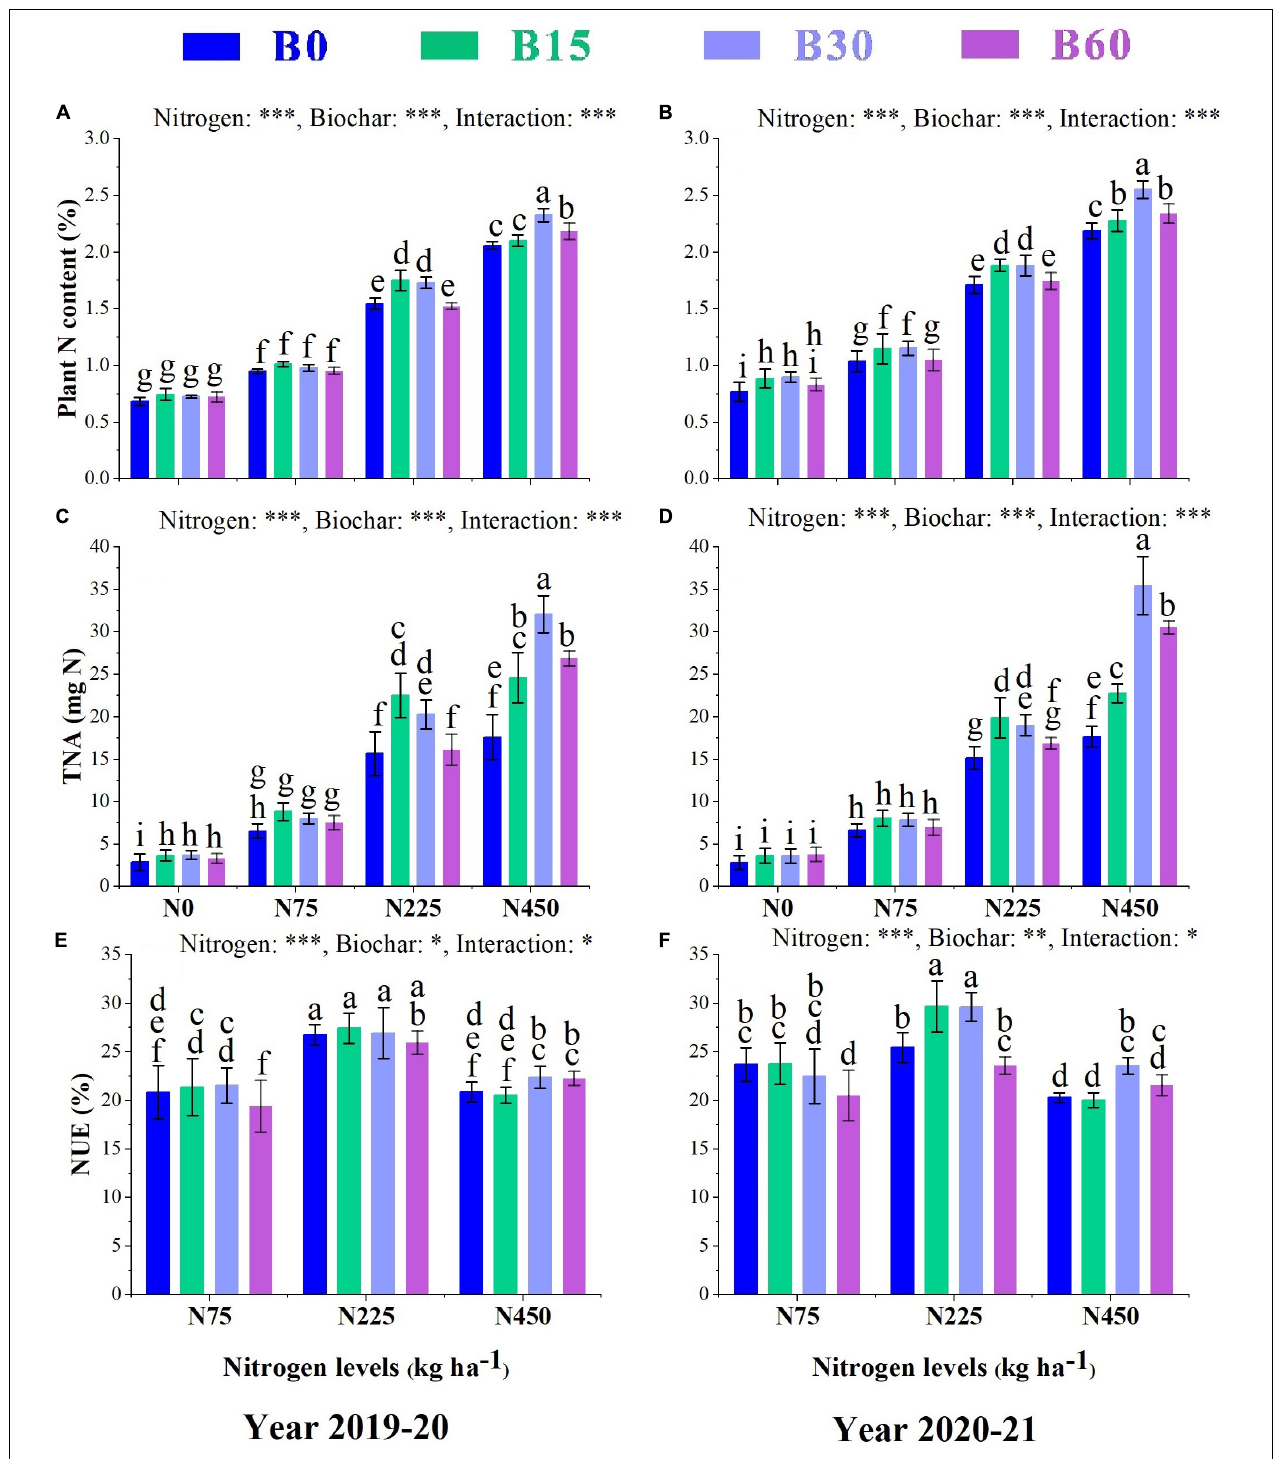
FIGURE 4 | Integral effects of biochar and nitrogen on plant N content (A) 2019–2020 and (B) 2020–2021, total nitrogen accumulation TNA (C) 2019–2020 and (D) 2020–2021 and nitrogen use efficiency (E) 2019–2020 and (F) 2020–2021. B0: 0 t ha − 1 biochar; B15: 15 t ha − 1 biochar; B30: 30 t ha − 1 biochar; B60: 60 t ha − 1 biochar; N0: 0 kg ha − 1 nitrogen; N75: 75 kg ha − 1 nitrogen; N225: 225 kg ha − 1 nitrogen, and N450: 450 kg ha − 1 nitrogen, error bars represent standard error for each treatment in three replicates. Different letters on each bar represent significant differences according to the LSD test ( p < 0.05).